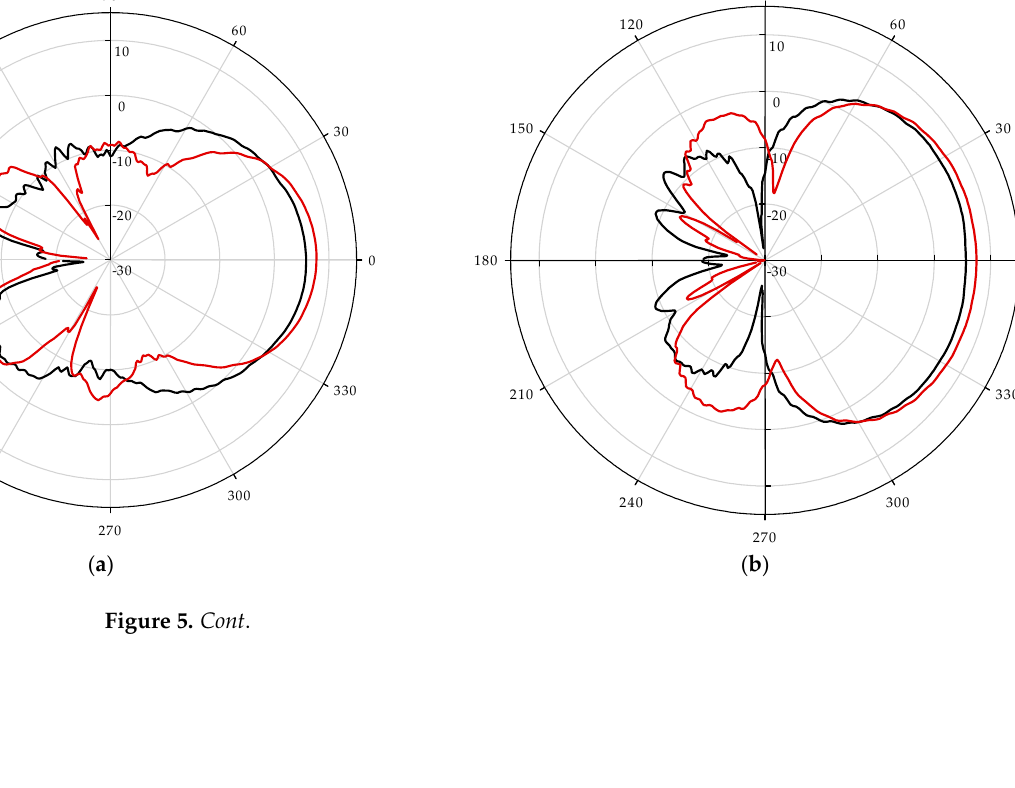
Figure 4. Simulated and measured result of the antenna: ( a ) return loss; ( b ) realized gain. Figure 5 illustrates the measured 2D radiation patterns of the designed antennas at 5, 6, 8, 10, and 13 GHz frequencies in the anechoic chamber room as shown in Figure 6c, using a far-field analysis system. The radiation patterns of the antenna are almost direc- tional in both the E-plane (x–y plane) and the H-plane (z–y plane), which is one of the required directive properties for podal and antipodal antennas. Figure 6a,b show the sim- ulated electric field distribution at 7 GHz; it can be seen that the electric field radiated due to a change in surface current at each tapering slot of the antennas superimposed to form a directive beam. Similarly, Figure 6c represents the measured 3 dB beamwidth of the constituent antenna whereas Figure 6d signifies simulated radiation efficiency.